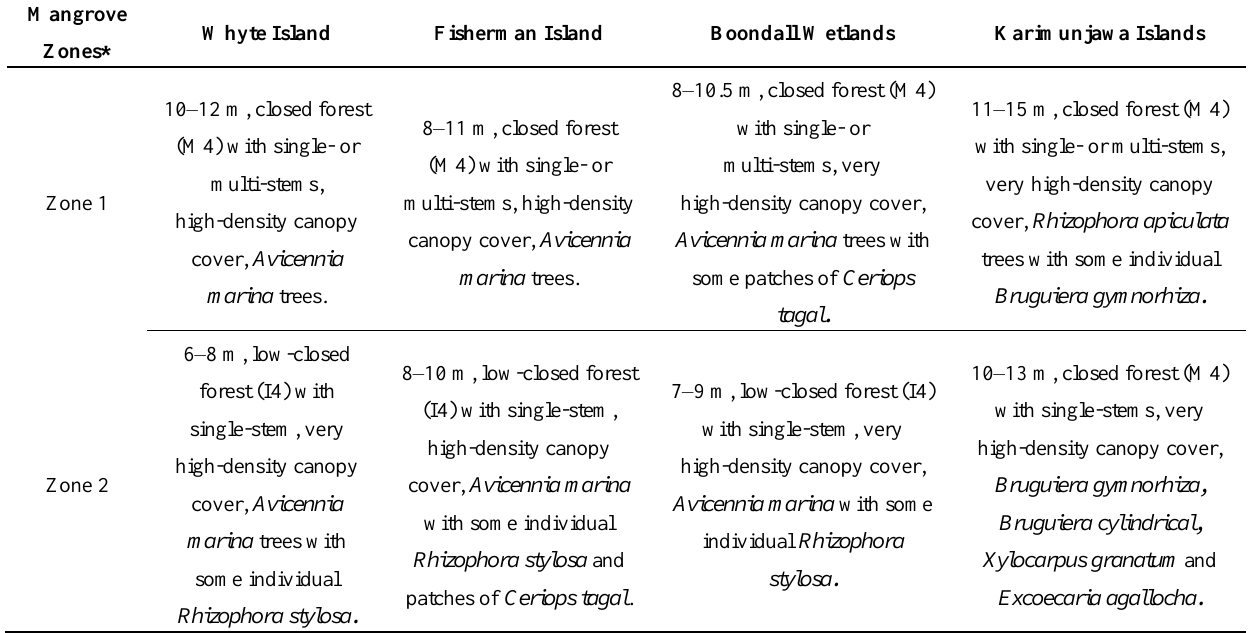
Table 2. Mangrove canopy height, formation type, canopy cover and dominant species derived from field data sampled across the vegetation zones at four study